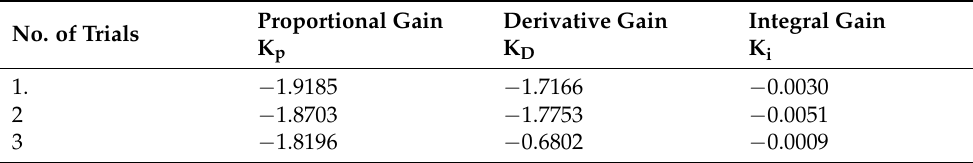
Table 6. Optimized GOA result for controller gains of network 2. [K A = 0.0861, K B = 0.4473 & K pp = 0.061].